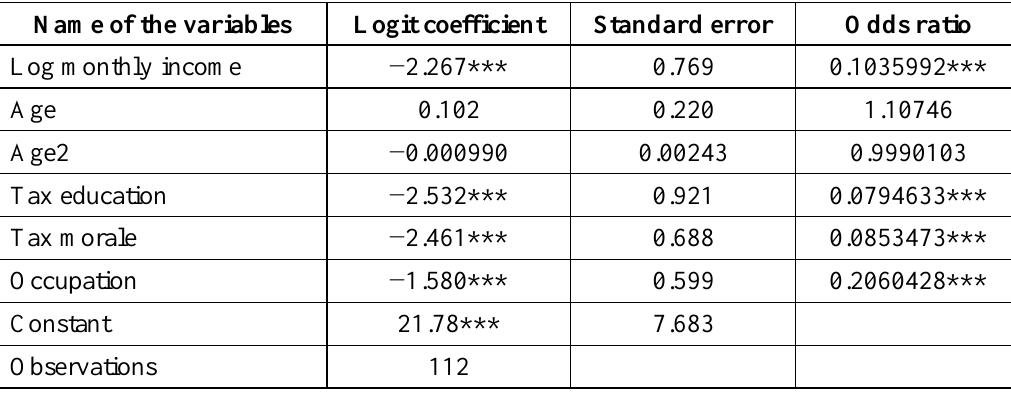
Table 3 . Income Tax Non-compliance